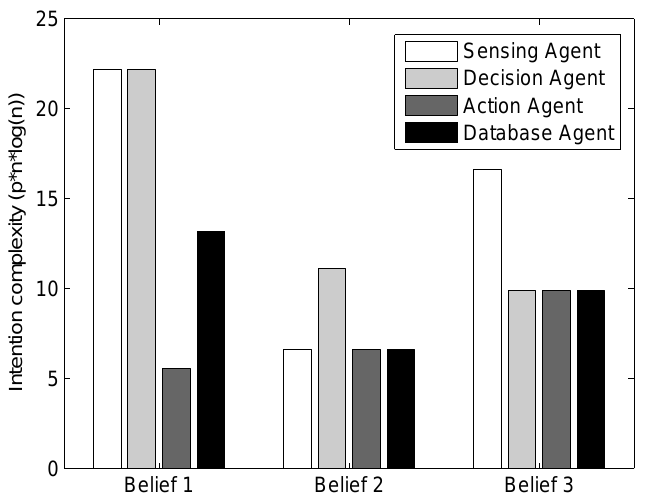
Figure 14. BDI models for four types of